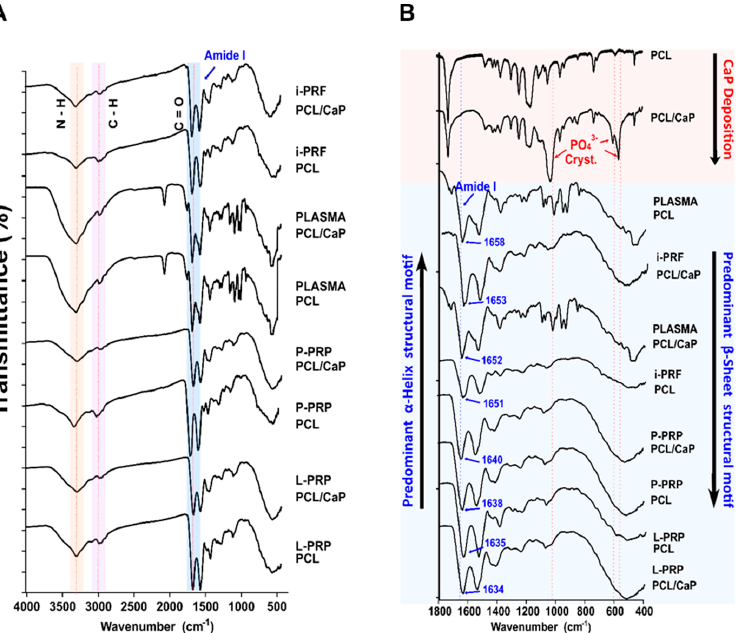
Figure 4. FTIR spectra for the various hemoderivatives and CaP scaffold combination. ( A ) All peaks in the N-H stretching region are significant above 3400 cm − 1 , especially on PLASMA/PCL/CaP. ( B ) Magnification of the stretching region encompassing 1800–400 cm − 1 confirmed apatite deposition on PCL (1028, 600 and 561 picks) and the predominant α -Helix structural motif for i-PRF and predominant β -sheet motif for the anticoagulated protocols (i.e., P-PRP, L-PRP observed in the Amide I region). Colored bands represent Amide A (orange/N-H) or B (purple/C-H) from 3300 and 2900 cm − 1 respectively, as well as Amide I (blue/ C=O) which appear at lower wavelengths from 1650 cm − 1